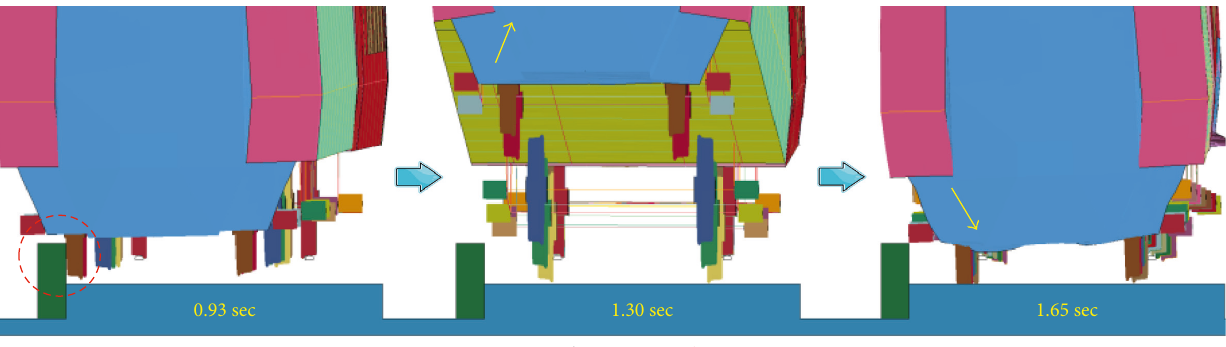
Figure 21: Derailment-collision behavior and impact force (height effect